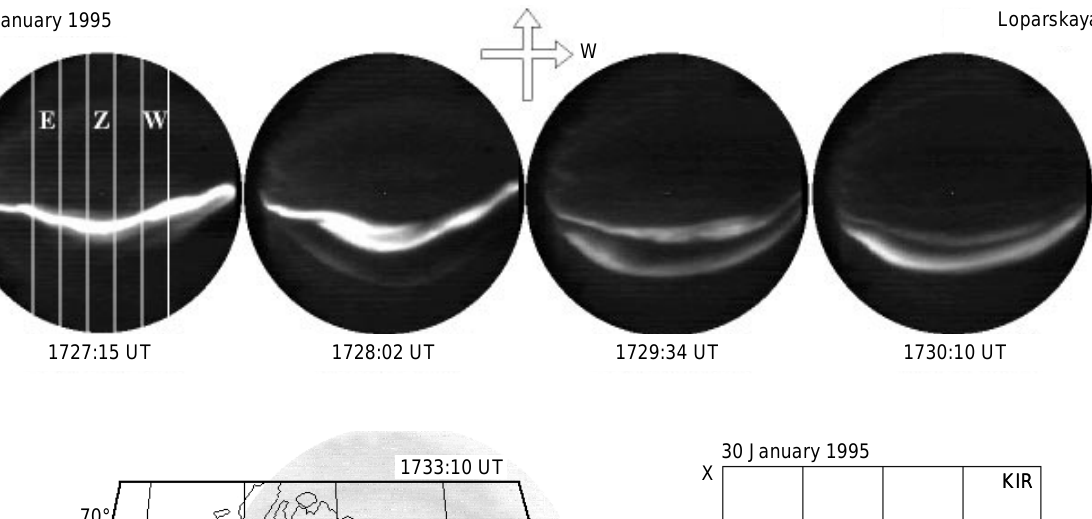
Fig. 2. Variations of the luminosity for two parallel auroral arcs as seen by TV-camera in Loparskaya; white lines on the first frame show three splits along which the (Z)enith, (E)astward and (W)estward profiles of the sky luminosity were obtained ( top ). Standard magnetograms showing the level of geomagnetic activity in Kiruna